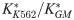
Relative changes in the PageRank and CheiRank in cancer vs normal network.The abscissa is the decimal logarithm of the ratio KK562/KGM, where the subscript denotes in which network the CheiRank is calculated. The ordinate is the decimal logarithm of the ratio KK562*/KGM*. For example, the proteins in the right part of the plot such as MEF2A, ZNF143, ZEB1 are those whose CheiRank significantly increased (i.e., the protein has less outgoing connections) in the “cancer network” K562 (which can be simply because the corresponding transcription factor is not present in K562 transcriptional network, as in the case of ZEB1, blue points in the plot).